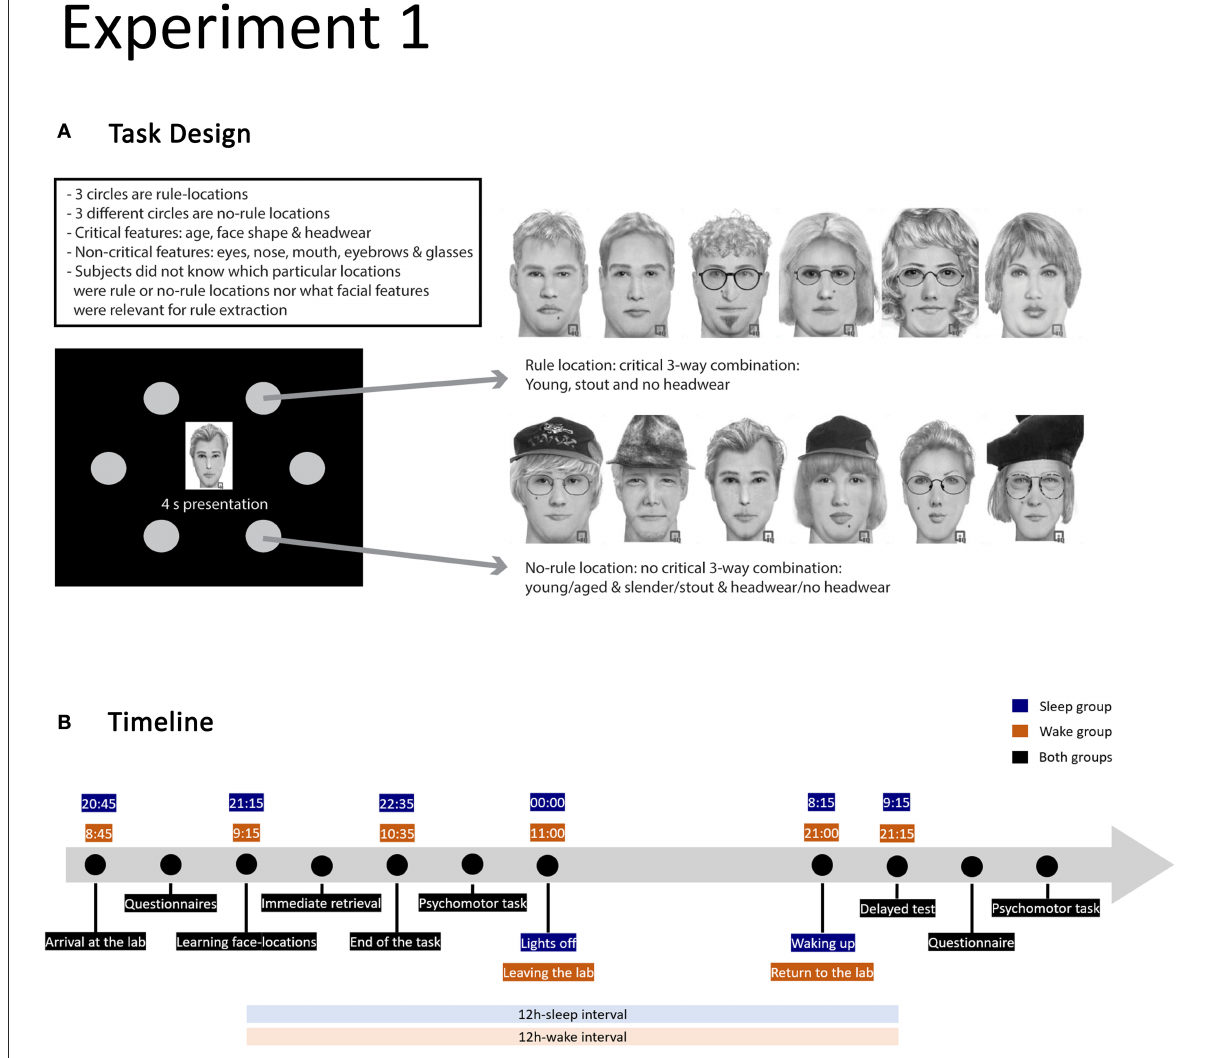
FIGURE1 Design of experiment 1. (A) Illustration of the task design with examples of faces for one rule and one no-rule location (adopted from Sweegers et al., 2014). The task features 3 rule and 3 no-rule locations with 12 faces associated with each location. The faces corresponding to a rule-location have a unique combination of three features (age, face shape, and headwear); each rule location features a different unique combination. For faces associated with the no-rule locations, the occurrence of critical features and their combinations is random. (B) Timeline of the experimental procedure in the sleep and wake